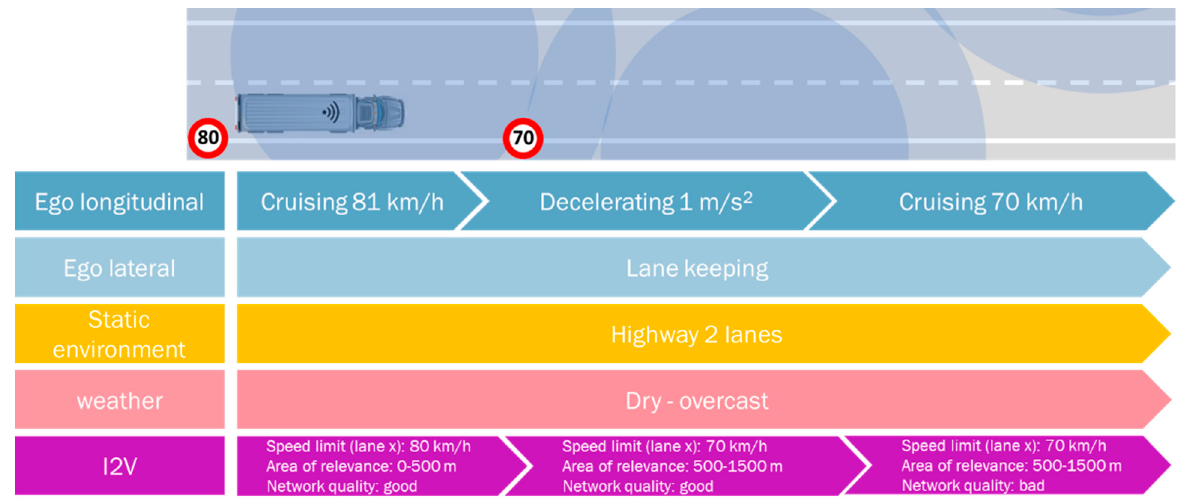
Figure 8. Example of a speed limit change that is communicated via the digital infrastructure to the leading truck in a platoon. In this example, a cellular network is used for the I2V communication. The blue circles in the upper figure represent the areas covered by different cellular networks. The example shows a speed limit change from 80 km/h to 70 km/h.